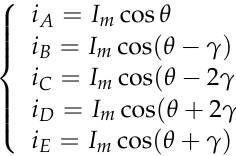
The reduced-order decoupling transformation matrices are the key to achieving the fault-tolerant operation for the FOC drive system. The input phase currents of the five- phase FTPMSM under normal conditions are expressed